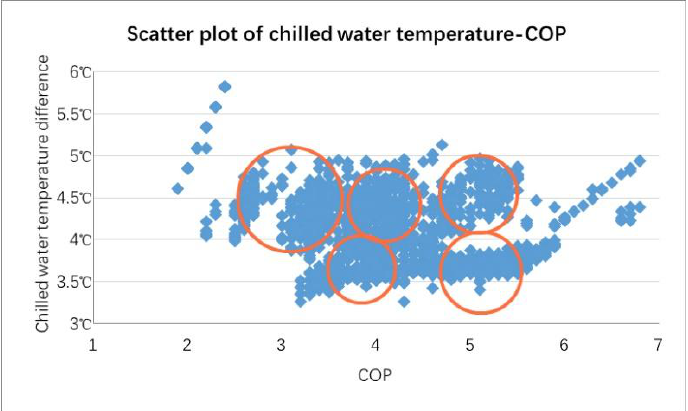
Figure 6. Scatter plot of CWTD-COP.